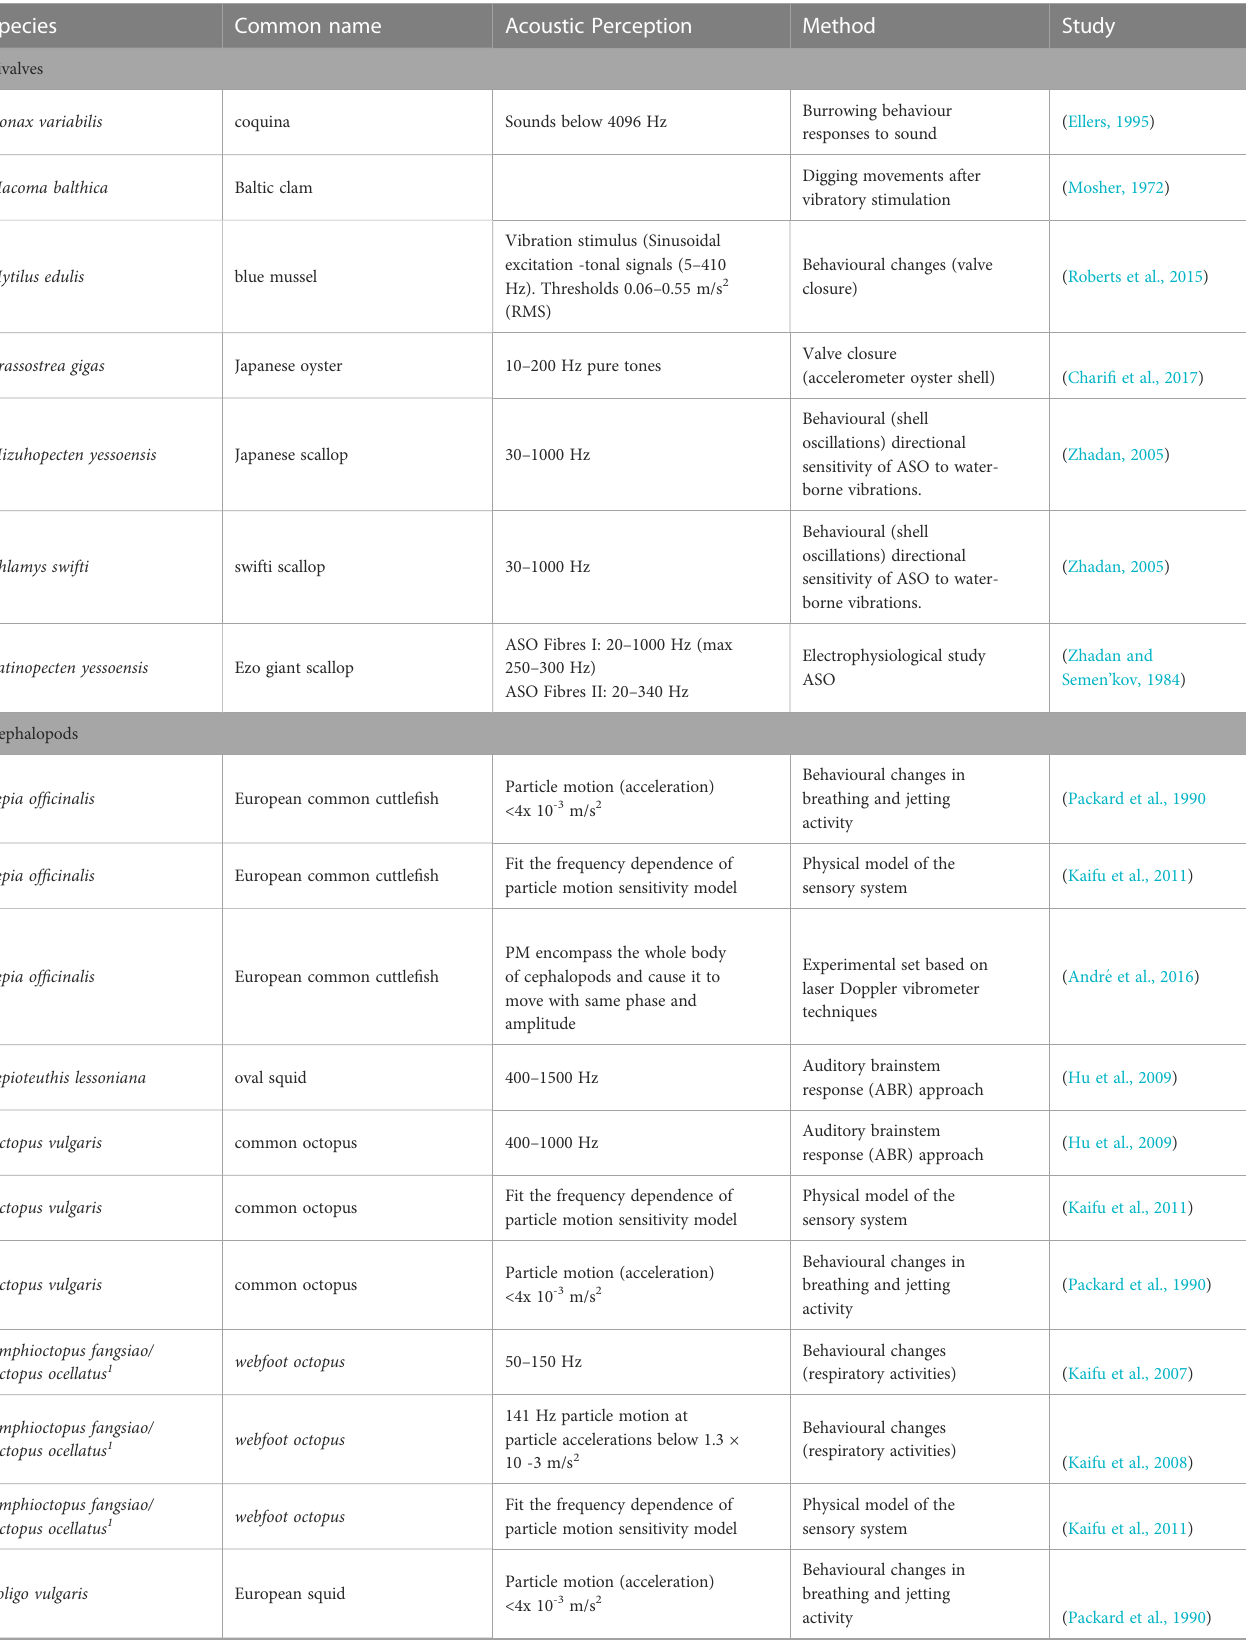
TABLE 2 Relevant studies on marine invertebrate acoustic